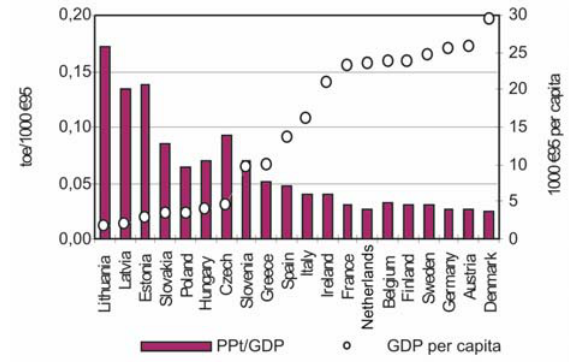
Fig 8. Intensity consumption of petroleum products in road transport and GDP per capita for different countries Dependences of consumption of petroleum products